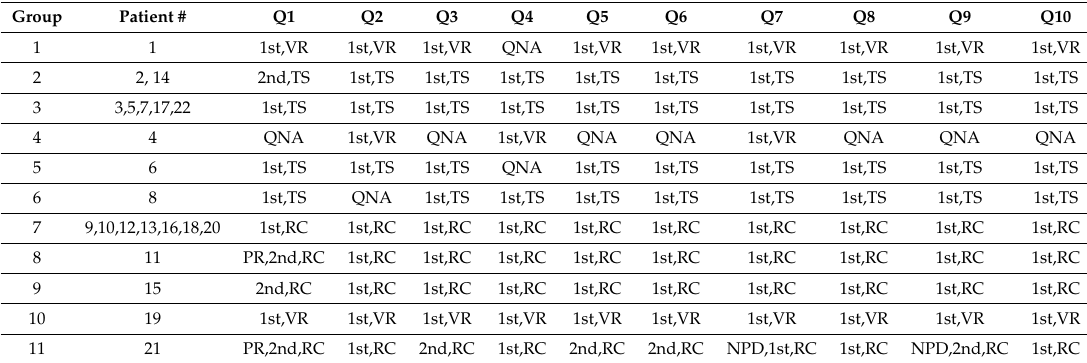
Barthel tests performed in real scenarios. 1st (FirstAttemptAnswered), 2nd (Second